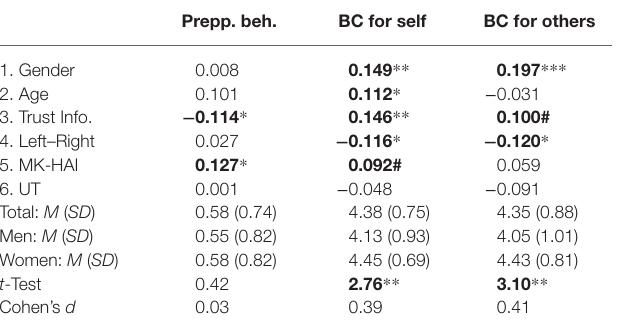
TABLE 2 | Means, SDs, and correlations for gender, age, trust in official information, political orientation, health anxiety and uncertainty tolerance with self-centered prepping behavior, behavior change to avoid infection, and behavior change in order to not infect others in Study 1. Prepp.